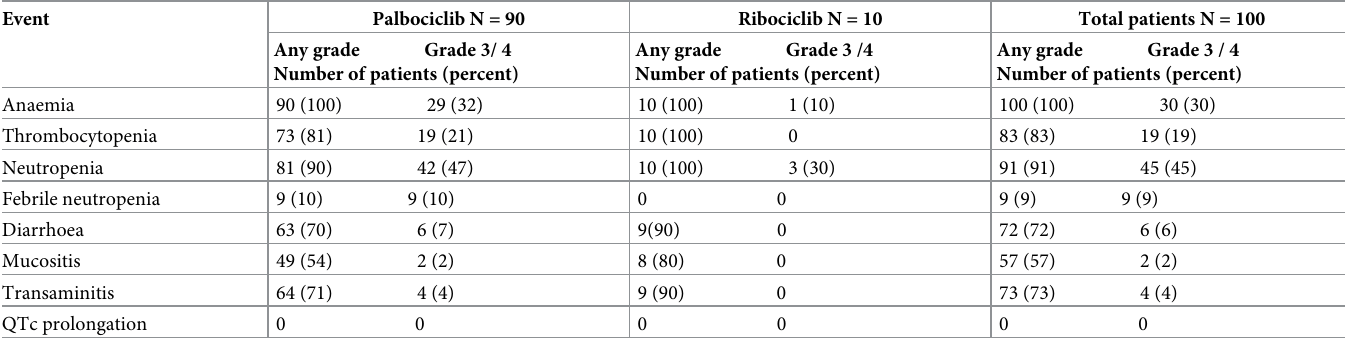
Table 2. Adverse events due to palbociclib and ribociclib.